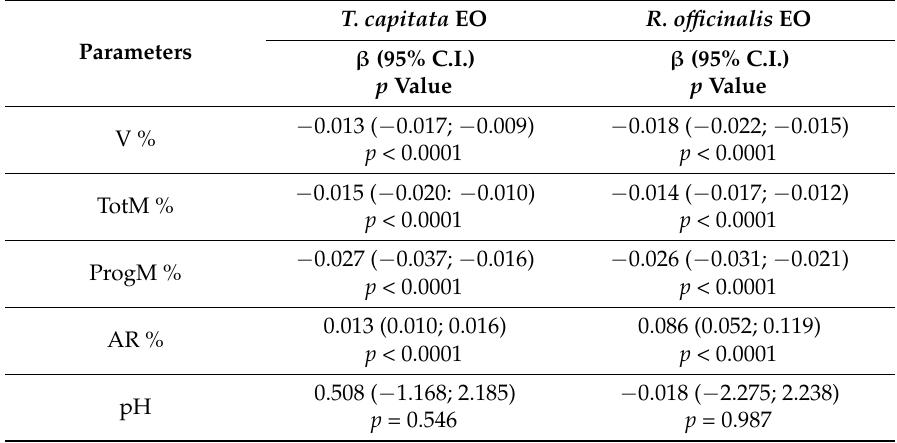
Table 3. Simple linear regression models’ angular coefficients ( β ).